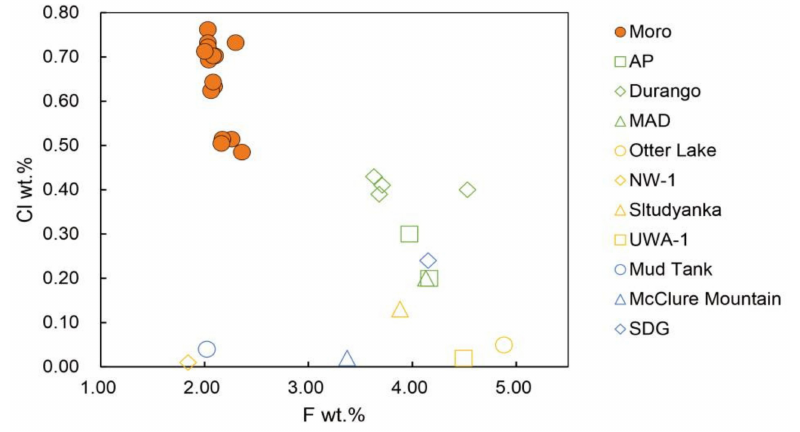
Figure 9. F–Cl diagram of apatites from different origins.